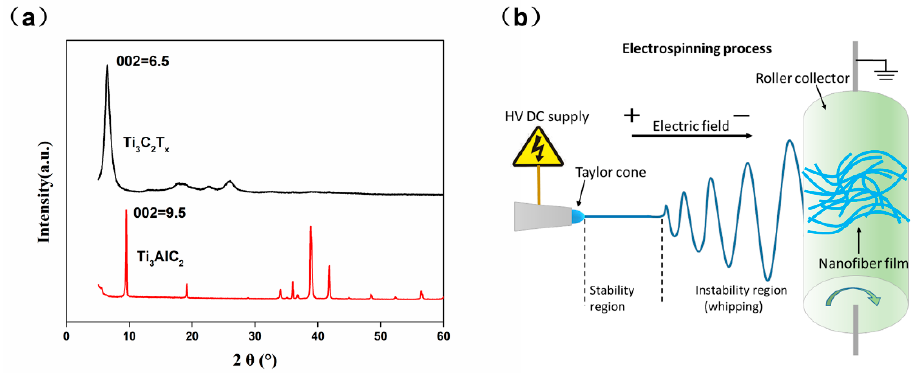
Figure 1. ( a ) XRD patterns of Ti 3 C 2 Tx and Ti 3 AlC 2 ; ( b ) Schematic diagram of electrospinning.